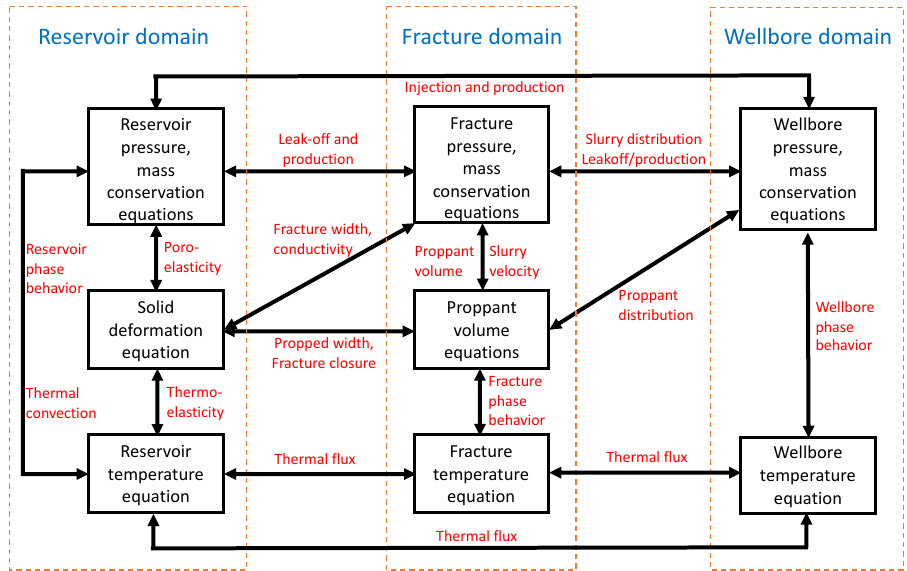
Figure 3. Solution domain and coupled physics in the simulator.